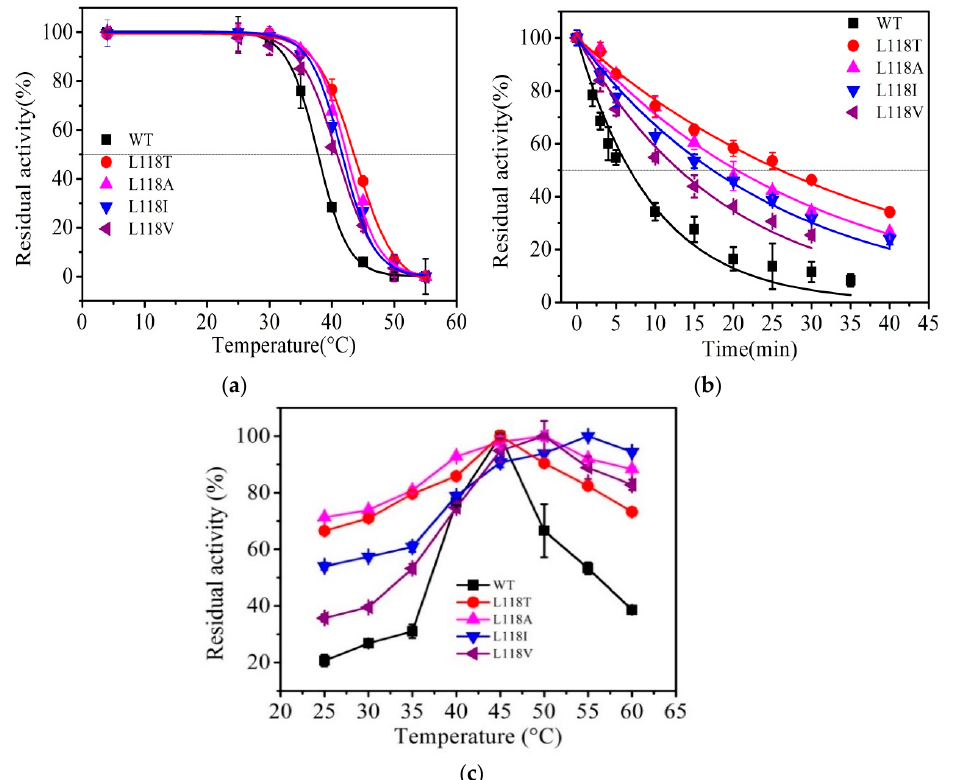
Figure 3. The thermal stability of wild-type AT-ATA and its mutants by the MI network: ( a ) The thermal deactivation of wild-type AT-ATA and the four variants at various temperatures for 10 min ( T 5010 ), ( b ) the thermal deactivation half-life ( t 1/2 ) of wild-type AT-ATA and the four variants at 40 °C, and ( c ) the effect of temperature on the activity of wild-type AT-ATA and the four variants determined by performing the reaction at pH 8.0 for 3 min. Black, Wild-type; red, L118T; magenta, L118A; blue, L118I; and purple, L118V. Table 1. The stability of the wild-type and stabilized mutant AT-ATAs.